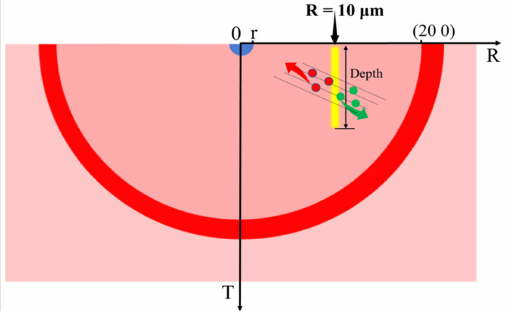
Figure 7. Schematic diagram of minimum ionizing particle (MIP) incidence and unbalanced carrier drift path.